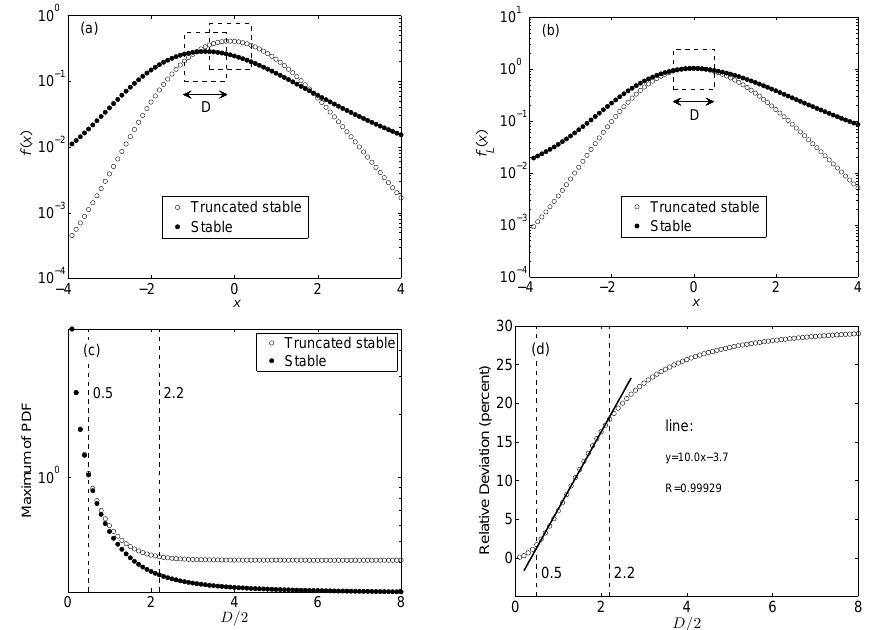
Fig. 1. Illustration of defining thresholds. (a) Comparison between truncated stable distribution and stable distribution. Parameters α = 1 . 5, β = 0 . 6, γ = 1, and λ = 1. The rectangle with a length of D in the direction of the x axis encloses the part that will be normalized. (b) Comparison between partly normalized truncated stable distribution and stable distribution. (c) Variations of maxima of partly normalized PDFs as a function of D/ 2. (d) Variations of absolute values of relative deviation between maxima of partly normalized PDFs as a function of D/ 2. According to the form of variations, this function can be divided into three regions that are marked out by dashed lines. Positions of the dashed lines on the x axis are also marked near these lines. The same dashed lines and corresponding positions are also marked in (c) . Linear fitting and its correlation coefficient R in the intermediate region are also shown in (d)